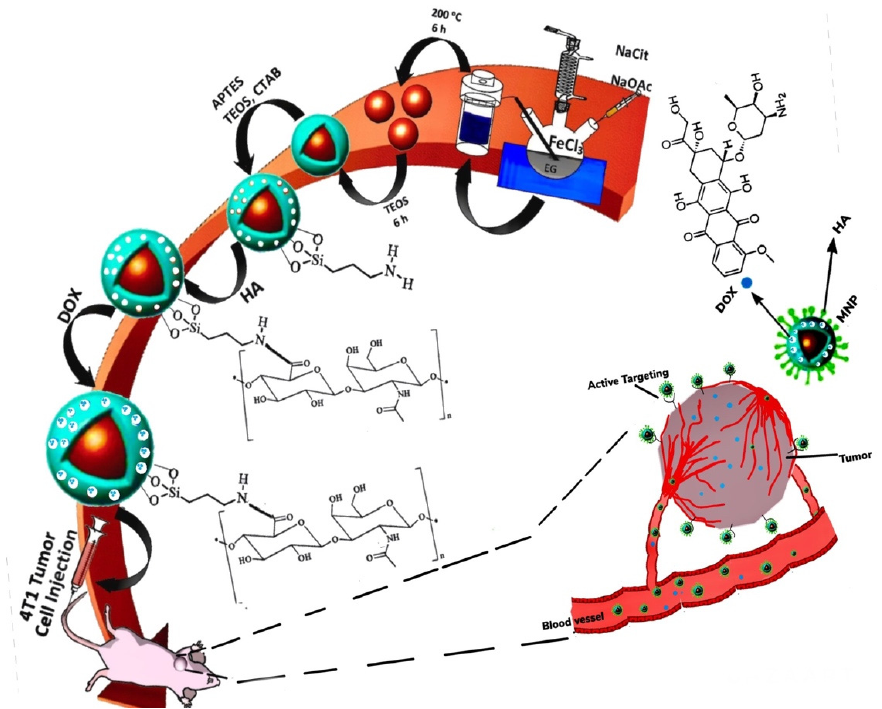
Figure 5. Schematic representation of an in vivo experimental procedure and the active targeting of DOX, and the cellular uptake by 4T1 cells following the administration. Redrawn from [282].